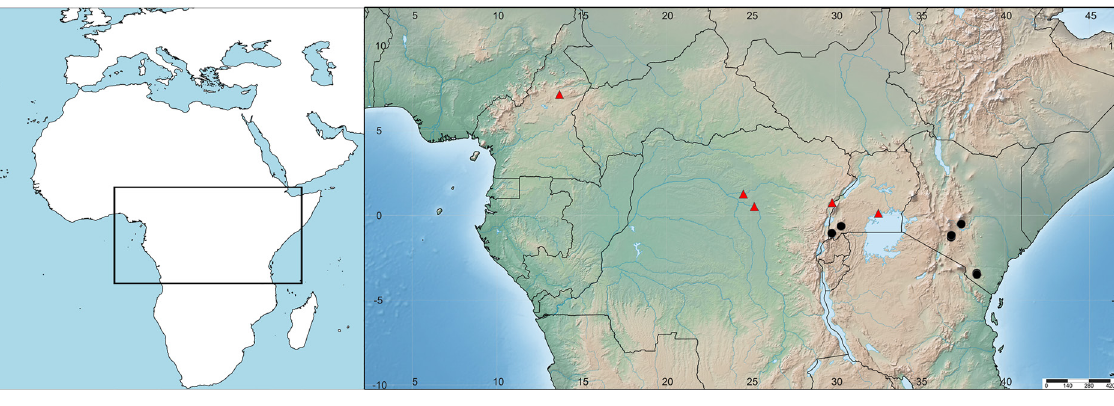
Fig. 2. Known distribution of Afrosyrphus varipes Curran, 1927 (red triangles) and Afrosyrphus schmuttereri sp. nov. (black